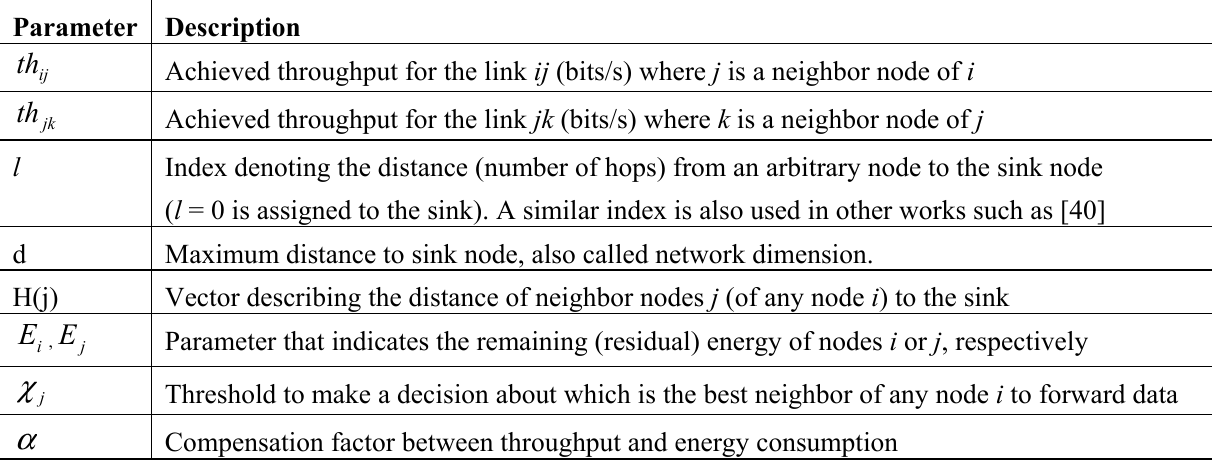
Table 3. Parameters defining the LOAM